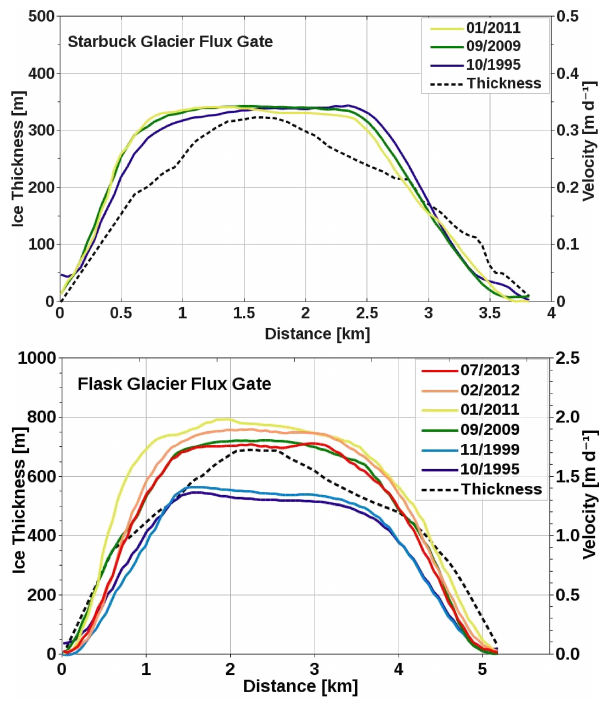
Figure 7. Ice thickness and surface velocity across the flux gate of Starbuck Glacier (top) and Flask Glacier (bottom). Ice thickness from Farinotti et al. (2013,